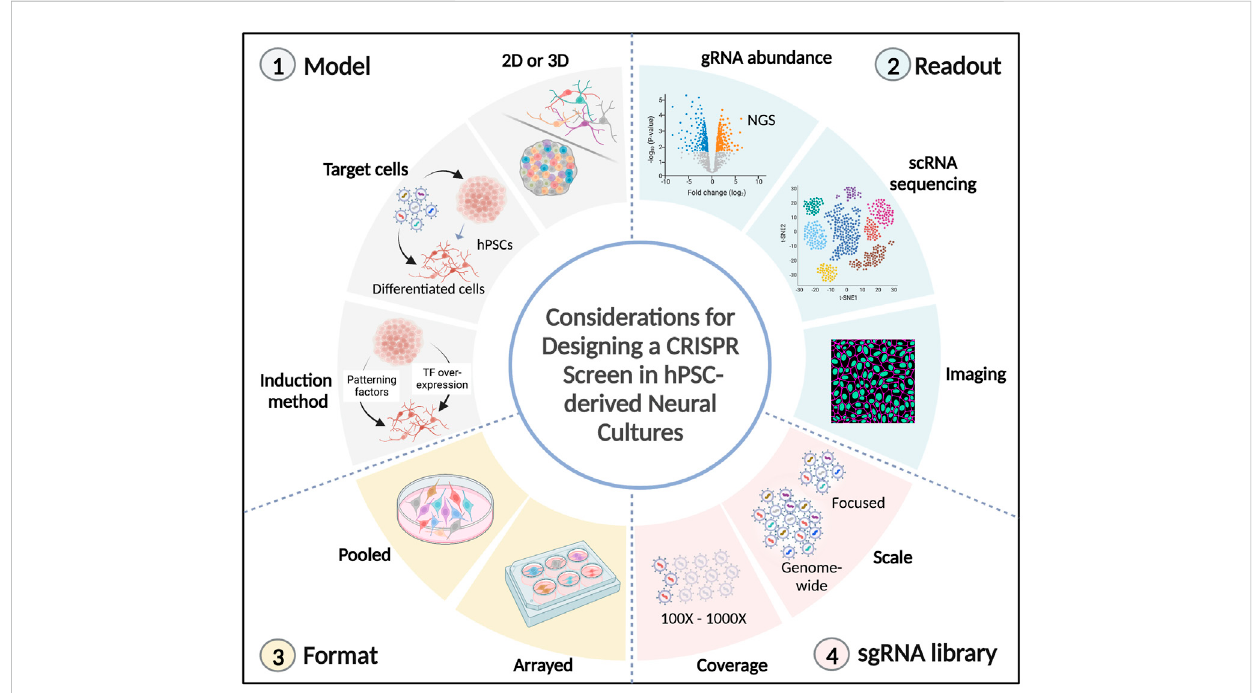
FIGURE 2 Technical considerations in CRISPR screens using hPSC-derived neural cultures. Several factors need to be considered in the design of a CRISPR screen using hPSC-derived neural cultures. 1) The model to be investigated. It can either be 2D (neural progenitors, neurons, or glial cells) or 3D (organoids/assembloids), the stage during which perturbations are induced (hPSCs or differentiated cells), and the differentiation method needs to be considered (extrinsic patterning factors or overexpression of transcription factors). 2) The desired readout. It can be the quanti fi cation of sgRNA abundances (following competition for cell survival or cell sorting), or high-content readouts, such as single-cell transcriptomics and spatial imaging. 3) Theformatofthescreen.Pooledperturbationscanbeintroducedtotargetcellsinbulkorinanarrayedformat(1perturbation/well).4)ThesgRNAlibrary. The scale of genes to be targeted (it can be genome-wide or a more focused library, such as the druggable genome, transcription factors or disease-risk genes).ThegRNAcoverageneedstobeconsidered,whichcanrangefrom100to1000foldrepresentationforeachsgRNA.TF:transcriptionfactor,NGS: next-generation